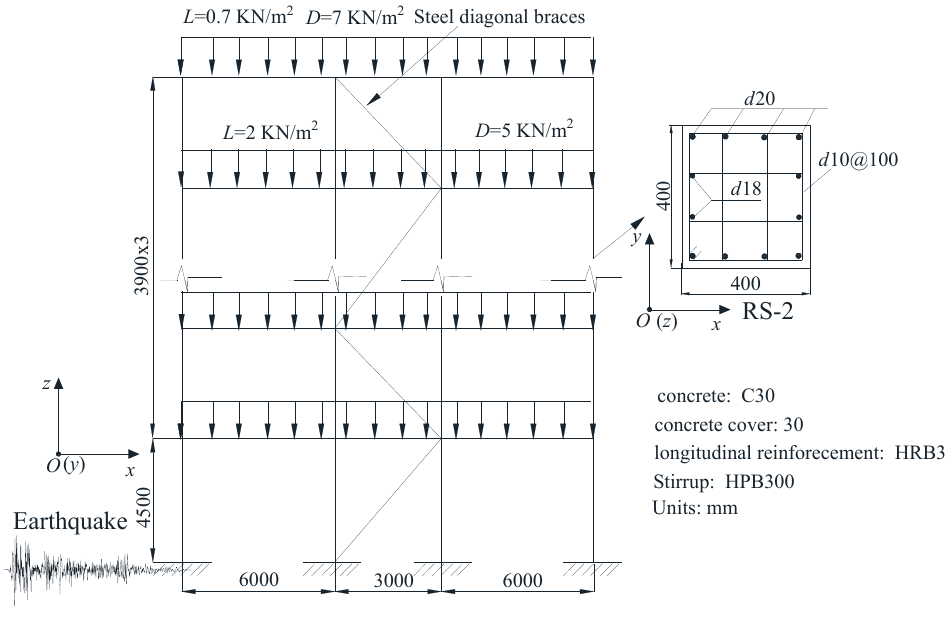
Figure 7. Steel diagonal braces RS-2.